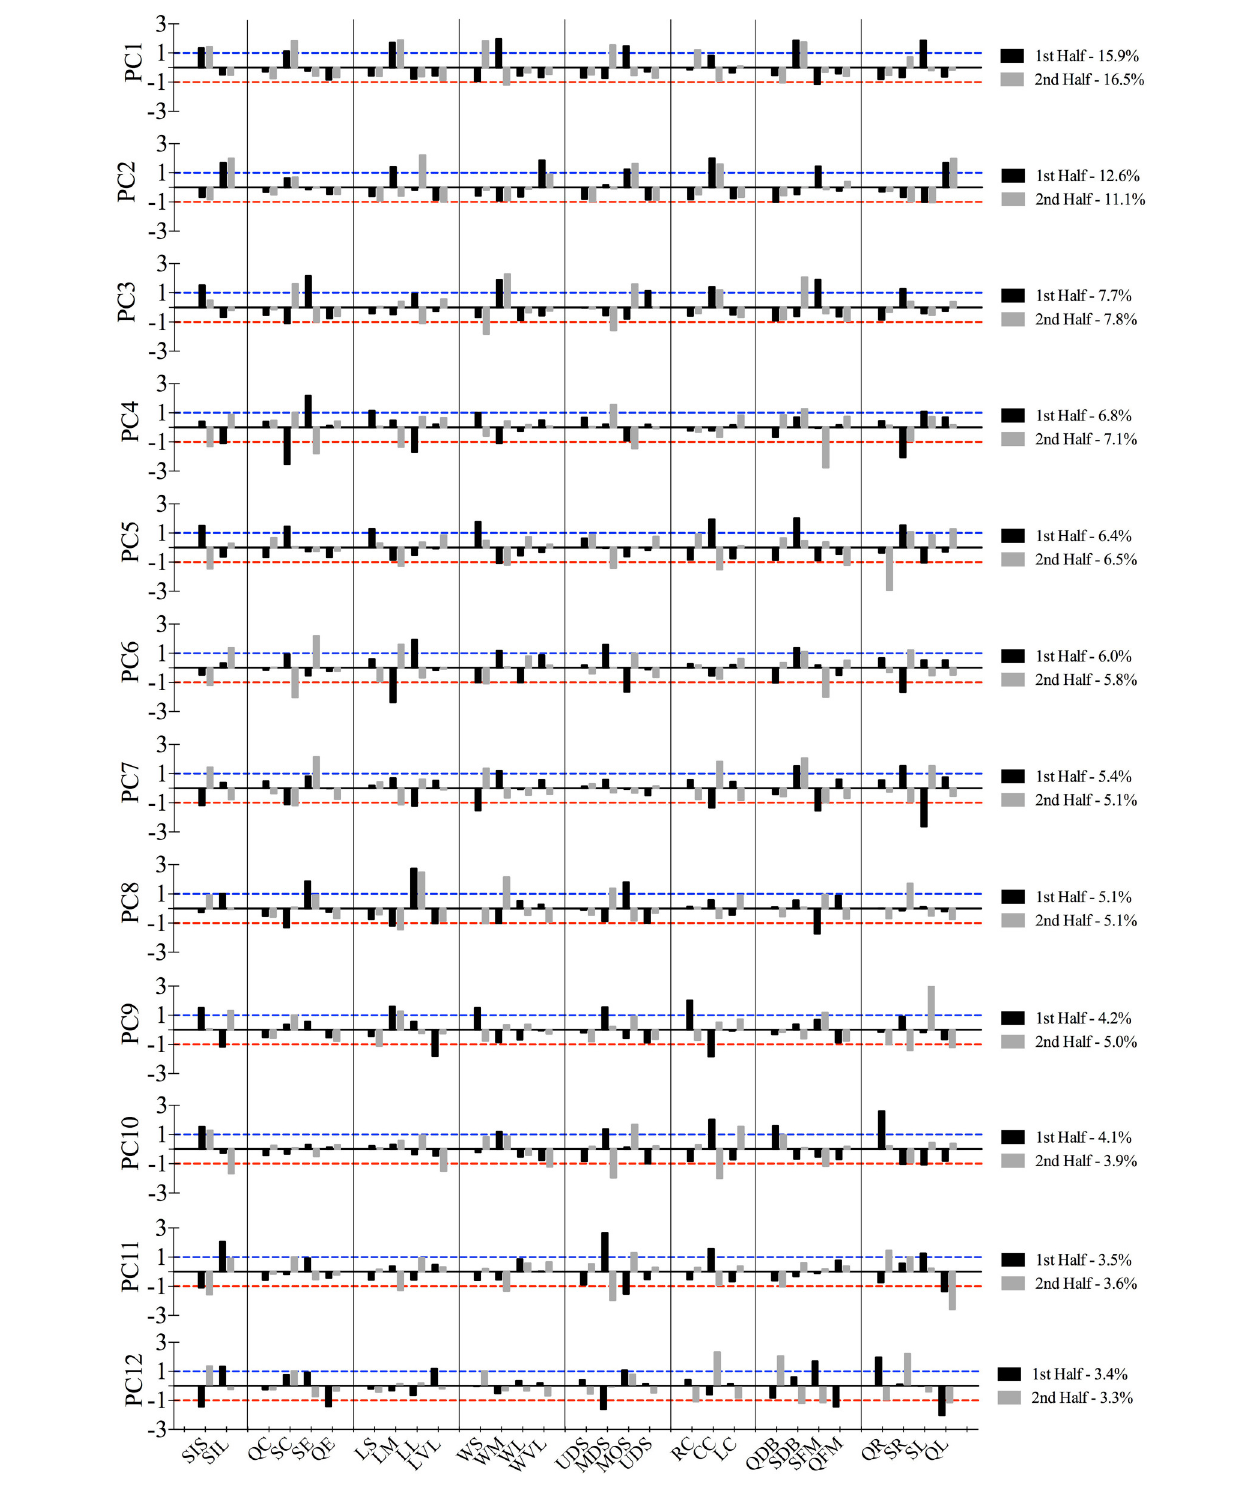
FIGURE 2 | Larger values than 1 (blue dashed line) and/or lower than − 1 (red dashed line) refer to the tactical behaviors that defined the primary-level of principal components.